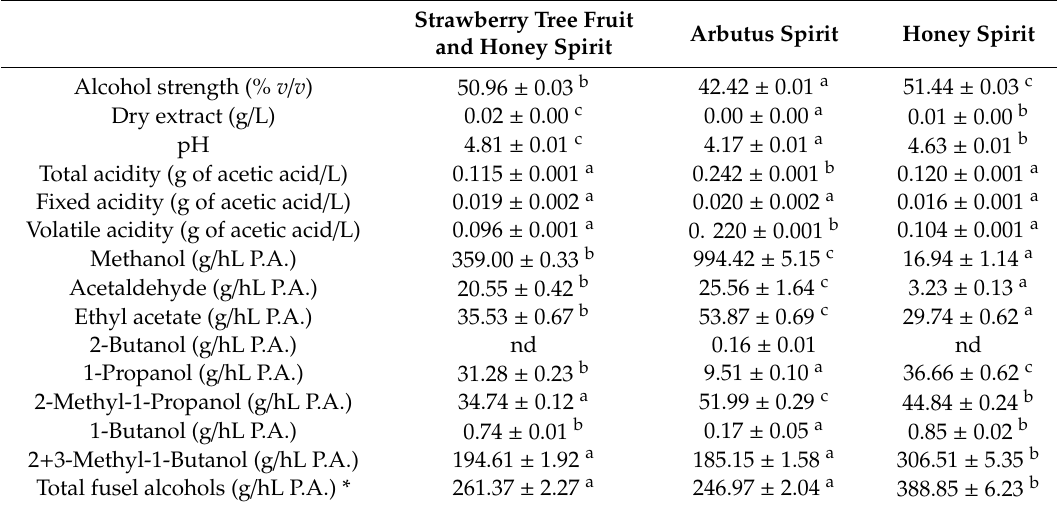
Table 1. Chemical characteristics of the new spirit made with strawberry tree fruit and honey (50:50 v / v ), arbutus spirit, and honey